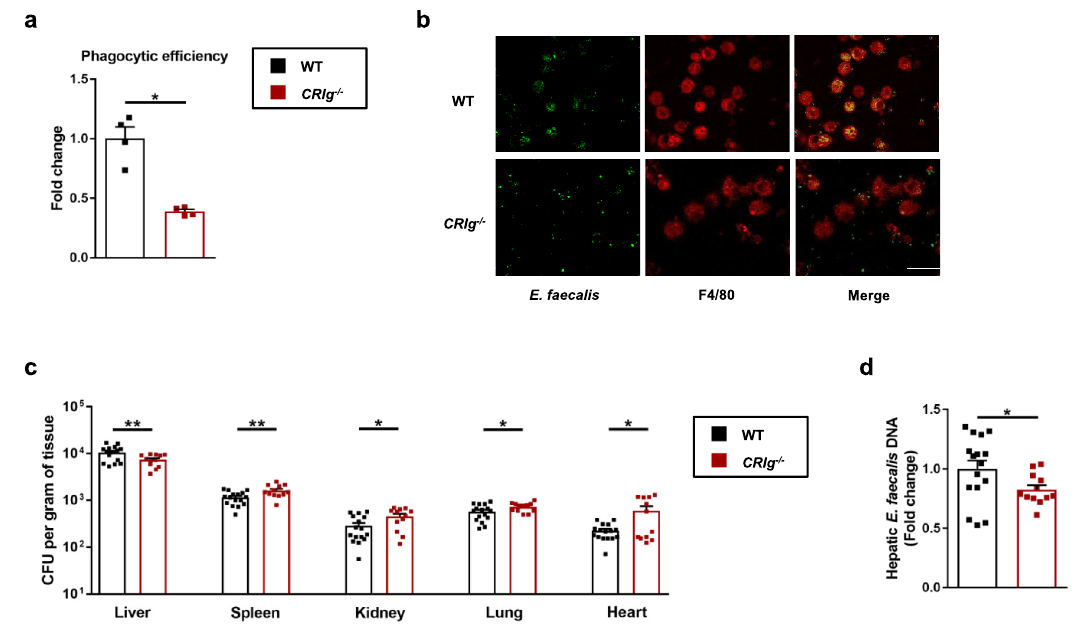
Fig. 4 CRIg is required for capturing of E. faecalis translocated from gut to the liver. a and b CRIg − / − mice and their WT littermates were placed on a chronic – binge ethanol diet and GFP- E. faecalis (2 × 10 7 CFUs) was intravenously injected 1 h after ethanol-binge. Mice were sacri fi ced 1 h after injection and Kupffer cells were isolated. a Quanti fi cation of the stained cells. b Representative microscopy pictures. c and d CRIg − / − mice and their WT littermates were fed the chronic-binge ethanol diet. One hour after the ethanol binge, mice were gavaged with E. faecalis (5 × 10 9 CFUs). Bacterial load ( c ) and DNA levels ( d ) were determined 20 min after bacterial gavage. Scale bar = 10 μ m. Results are expressed as mean ± s.e.m. ( a , c , d ). P values determined by two-sided Mann – Whitney test ( a , c , d ). * P < 0.05, ** P <